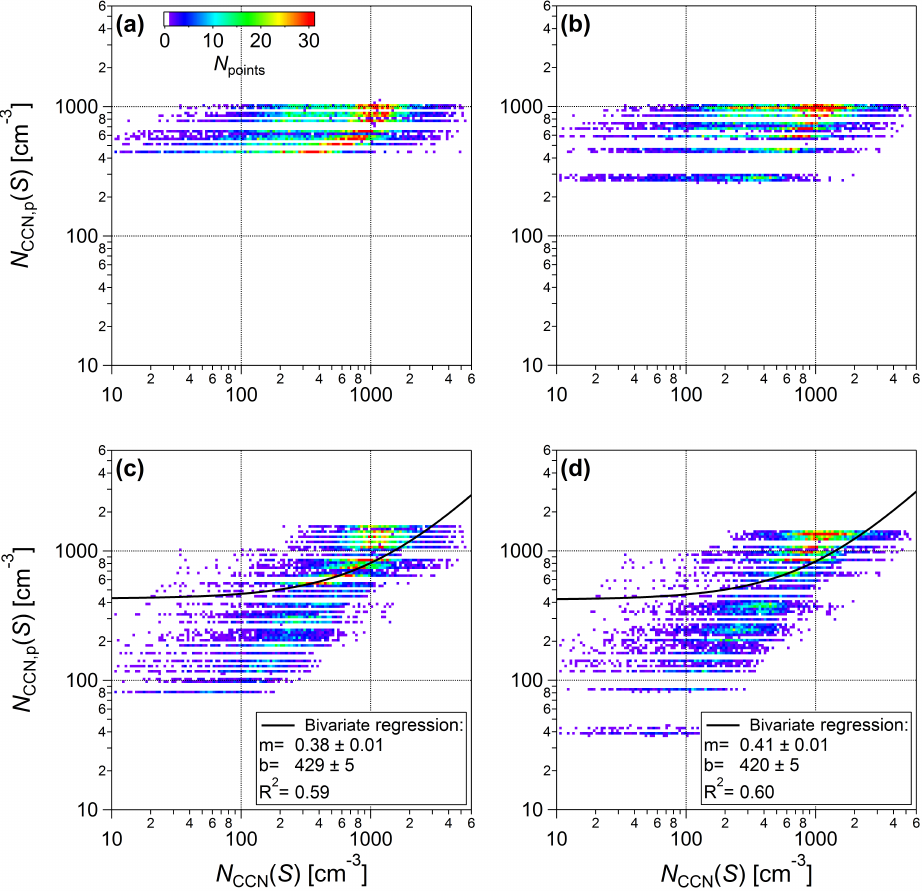
Figure 11. Predicted vs. measured CCN number concentrations based on the classical Twomey power-law fit (a, c) and an alternative error function fit (b, d) . The top row (a, b) represents the annually averaged cases, whereas the bottom row (c, d) represents parametrizations based on seasonally resolved CCN spectra. Both predictions are based exclusively on the corresponding average fit functions (i.e., the annually averaged CCN spectra in Fig. 10 and seasonally averaged CCN spectra, as specified in Tables 5 and 6) without considering time-resolved aerosol parameters. The color code shows the number of data points falling into the pixel area, following Jurányi et al. (2011). Predicted and measured CCN concentrations deviate significantly, showing the inherent limitations of the CCN spectra approach. For the annually averaged data (a, b) , no meaningful bivariate regression fit could be